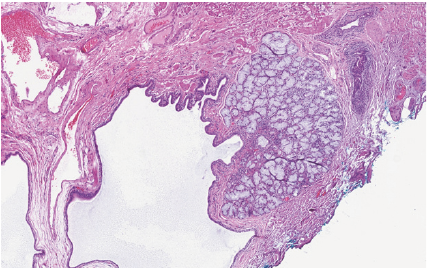
Figure 6: Higher magnification image showing the ectatic venous channels as well as a lobule of heterotopic minor salivary